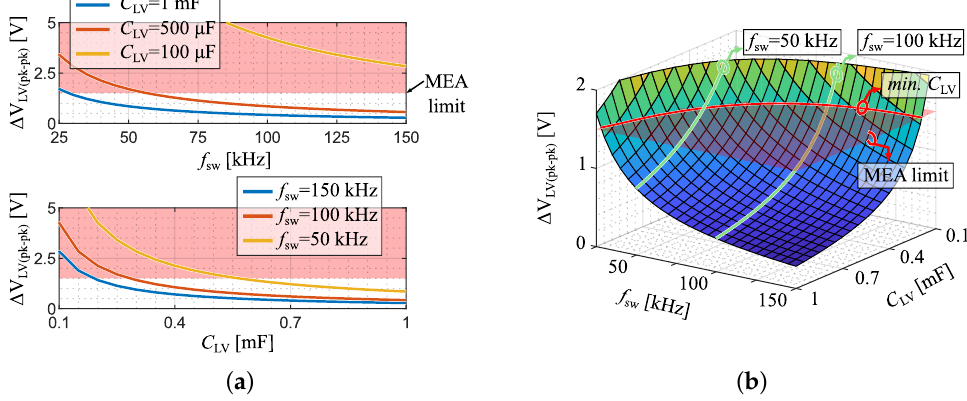
Figure 8. ( a , b ): Influence of output capacitance ( C LV ) and switching frequency ( f sw ) on the peak-to- peak voltage ripple ( ∆ V pk − pk